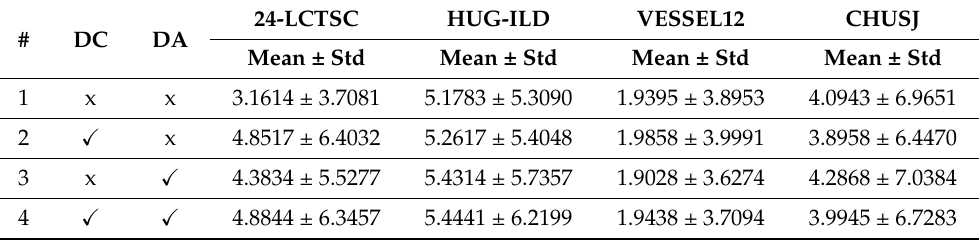
Table 4. Mean and standard deviation (std) results of the Hausdorff distance (HD) for each dataset and for each experiment. For simplicity purposes, a number is assigned to each experiment, as indicated in the first column, # . The DA column corresponds to the data augmentation and the DC column corresponds to the data correction. The value x in these two columns indicates experiments without DA or DC and the value (cid:88) indicates experiments with DA or DC. The values of the HD can lie in the range 0–181.0193